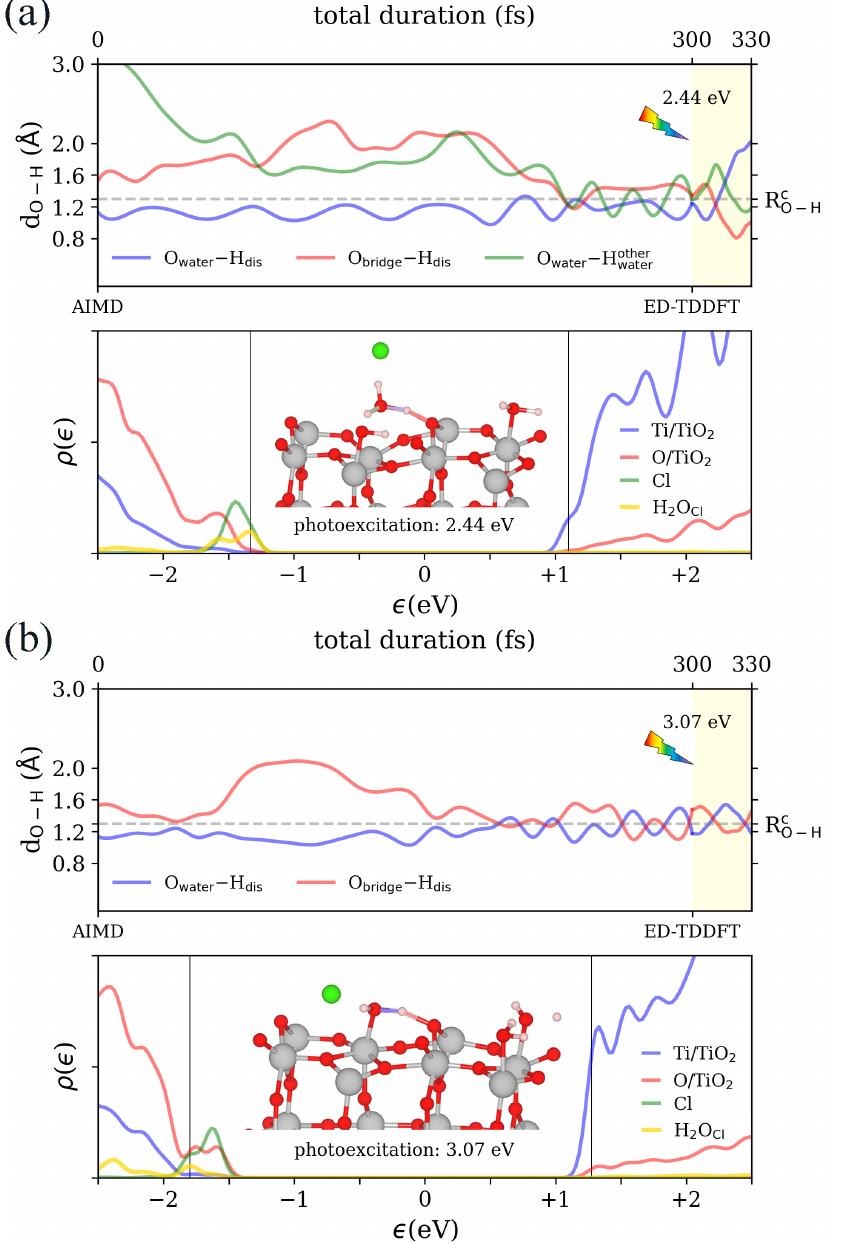
Figure 3. Time evolved O–H bond length (d O − H ) for the total duration and density of states (DOS) for determining the excitation energy after AIMD run. The d O − H of ( a ) fully dissociated reaction and ( b ) dissociated hydrogen (H dis ) oscillated to the oxygen between the dissociated water (O water ) and bridge sites (O bridge ) are recorded during AIMD and ED–TDDFT, which are involved in H 2 O Cl adsorbate for O water –H dis (blue lines) and O bridge –H dis (red lines). The O water –H other (green lines) represent that water the O water molecule dissociating or associating with hydrogen from another water molecule. The grey dashed lines represent the R C equal to 1.3 Å. The DOSes corresponding to ( a , b ) at the simulation of O − H 300 fs are, respectively, shown in on the bottom panels, and the middle of its band gap is defined as the zero of the energy. The insets in the bottom panels of ( a , b ) show the initial geometric structures used for ground state calculations of the DOS. The projections of Ti/TiO 2 , O/TiO 2 , Cl, and H 2 O Cl are colored by blue, red, green and yellow solid lines, respectively. Two vertical black lines around the band gap represent the CBM and designed VB, which relate the energy gap between the CBM and the first peak of H 2 O Cl